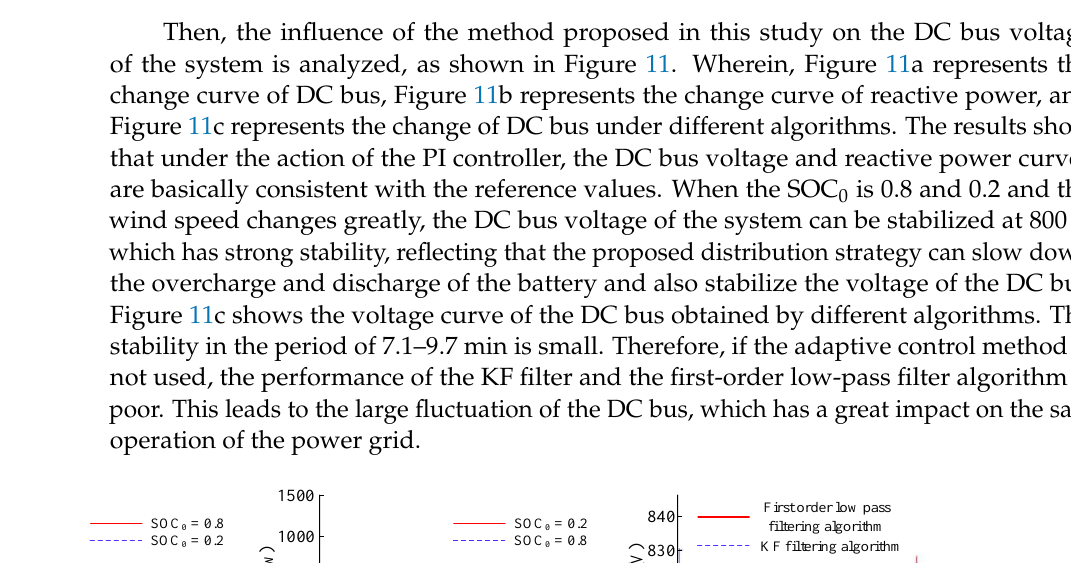
Figure 10. Battery SOC change curve.